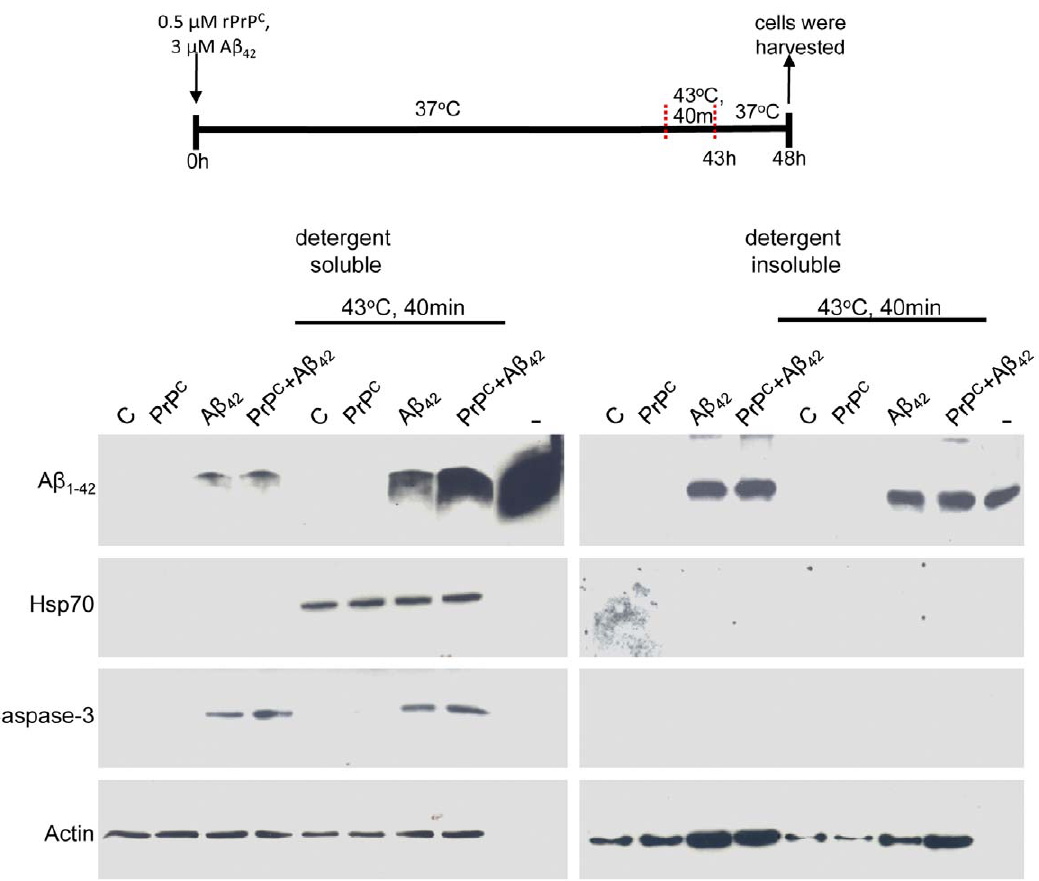
Figure 2. Heat shock initially increases A b 42 association with CAD neural cells. In four independent experiments CAD cells were incubated with 3 m M A b 42 and/or 0.5 m M bovine rPrP C , after , 42 hours cells were subjected to heat-shock at 43 u C for 40 minutes and then allowed to recover for 5 hours. The cells were rinsed in PBS and lysed. 30 m g of the soluble protein or 10 m l of the insoluble fraction was resolved by SDS-PAGE and subjected to Western blot analysis. Data are representative of 4 separate experiments.